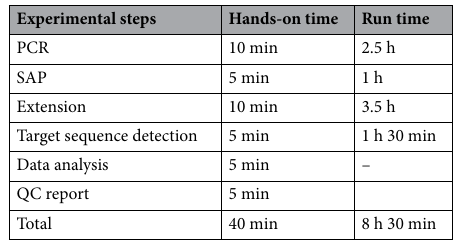
Table 2. Experimental steps for Agena iPLEX Sample ID Plus